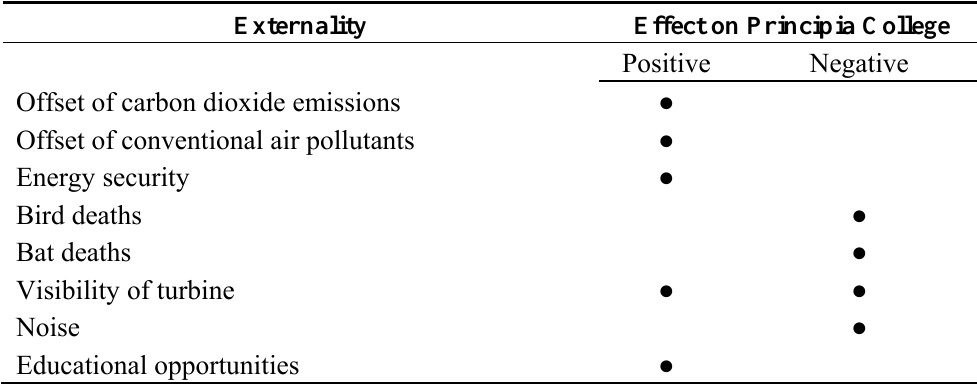
Table 1. Externalities produced by a wind